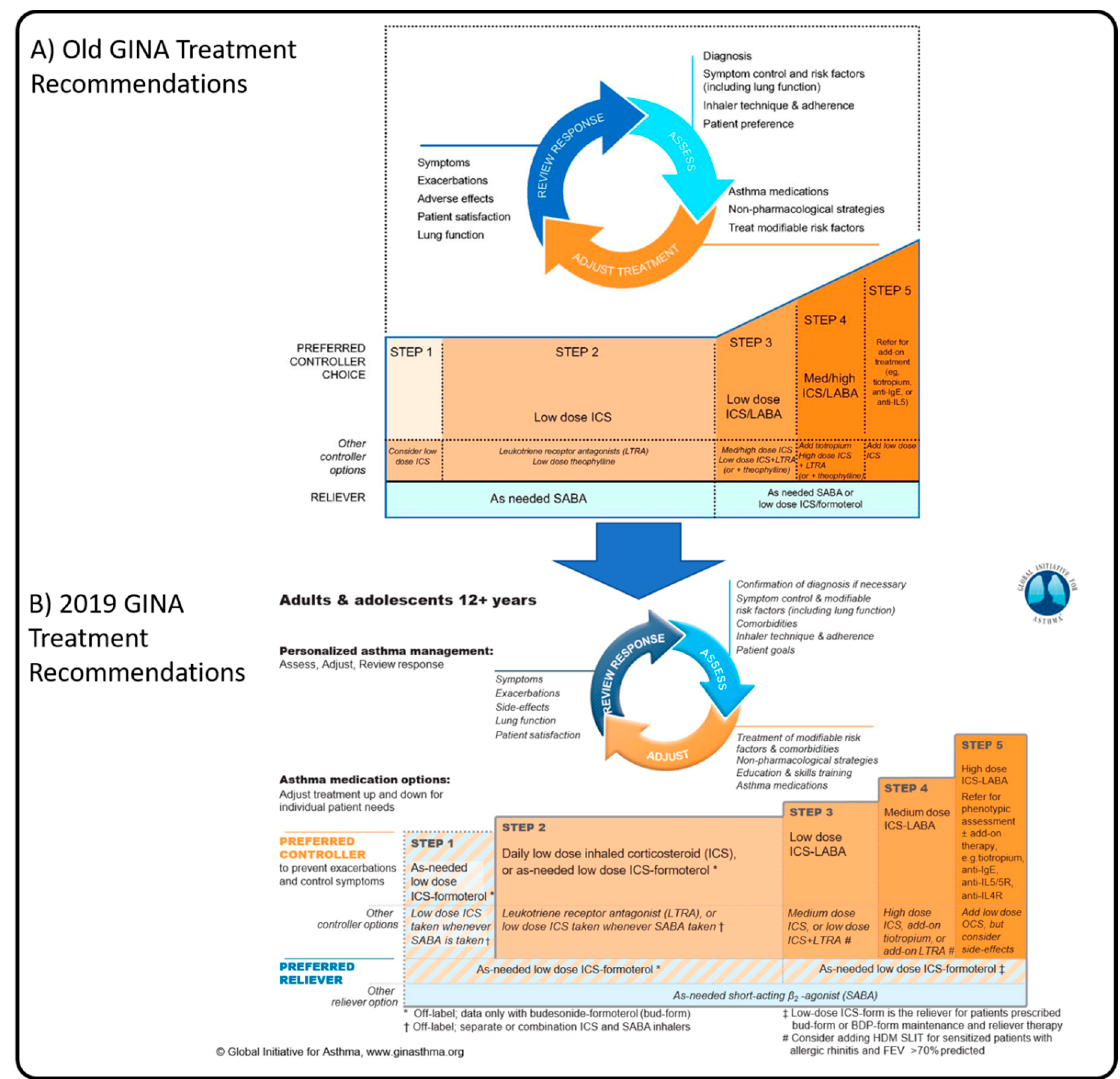
Figure 1. Personalized management for adults and adolescents from the Global Initiative for Asthma Global Strategy for Asthma Management and Prevention for 2018 ( A ) and 2019 ( B ), illustrating the changes to the recommended management in the newest strategy. Adapted from GINA 2018 [26] and GINA 2019 [1]. BDP: beclomethasone dipropionate; FEV: forced expiratory volume; HDM: house dust